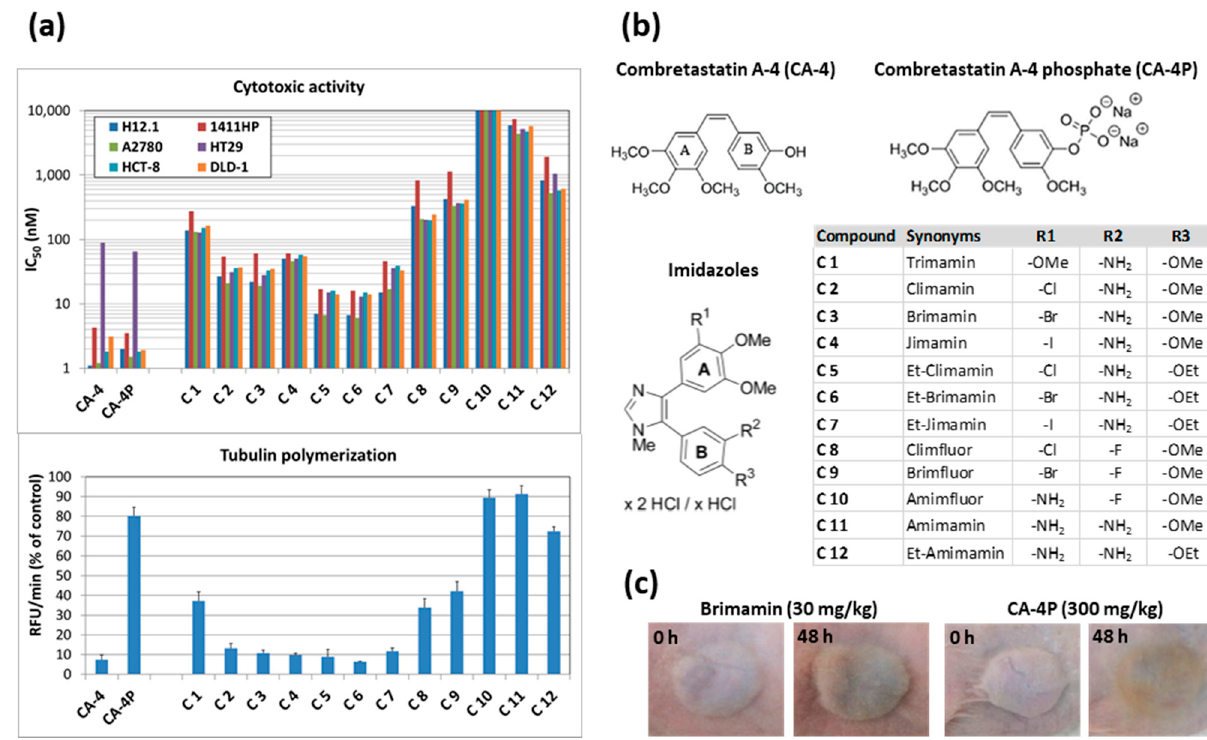
Figure 1. Structure–activity relationship study of imidazoles C 1–C 12 compared with CA-4 and CA-4P. ( a ) Combined cytotoxicity and tubulin polymerization assay. Displayed are the means of IC 50 values of compounds against a panel of six different cell lines (upper diagram). Tubulin polymerization is quantified as relative fluorescence units per minute and is given as percent of untreated control (lower diagram). ( b ) Structures of combretastatin A-4 (CA-4) and combretastatin A-4 phosphate (fosbretabulin) and of N -methyl-4-(4,5-dimethoxyphenyl)-5-phenyl-imidazolium hydrochlorides C 1–C 12 with variation in residues R 1 , R 2 , and R 3 as specified. ( c ) Representative examples of 1411HP xenograft tumors before and 48 h after treatment, showing typical discoloration indicating a vascular-disrupting